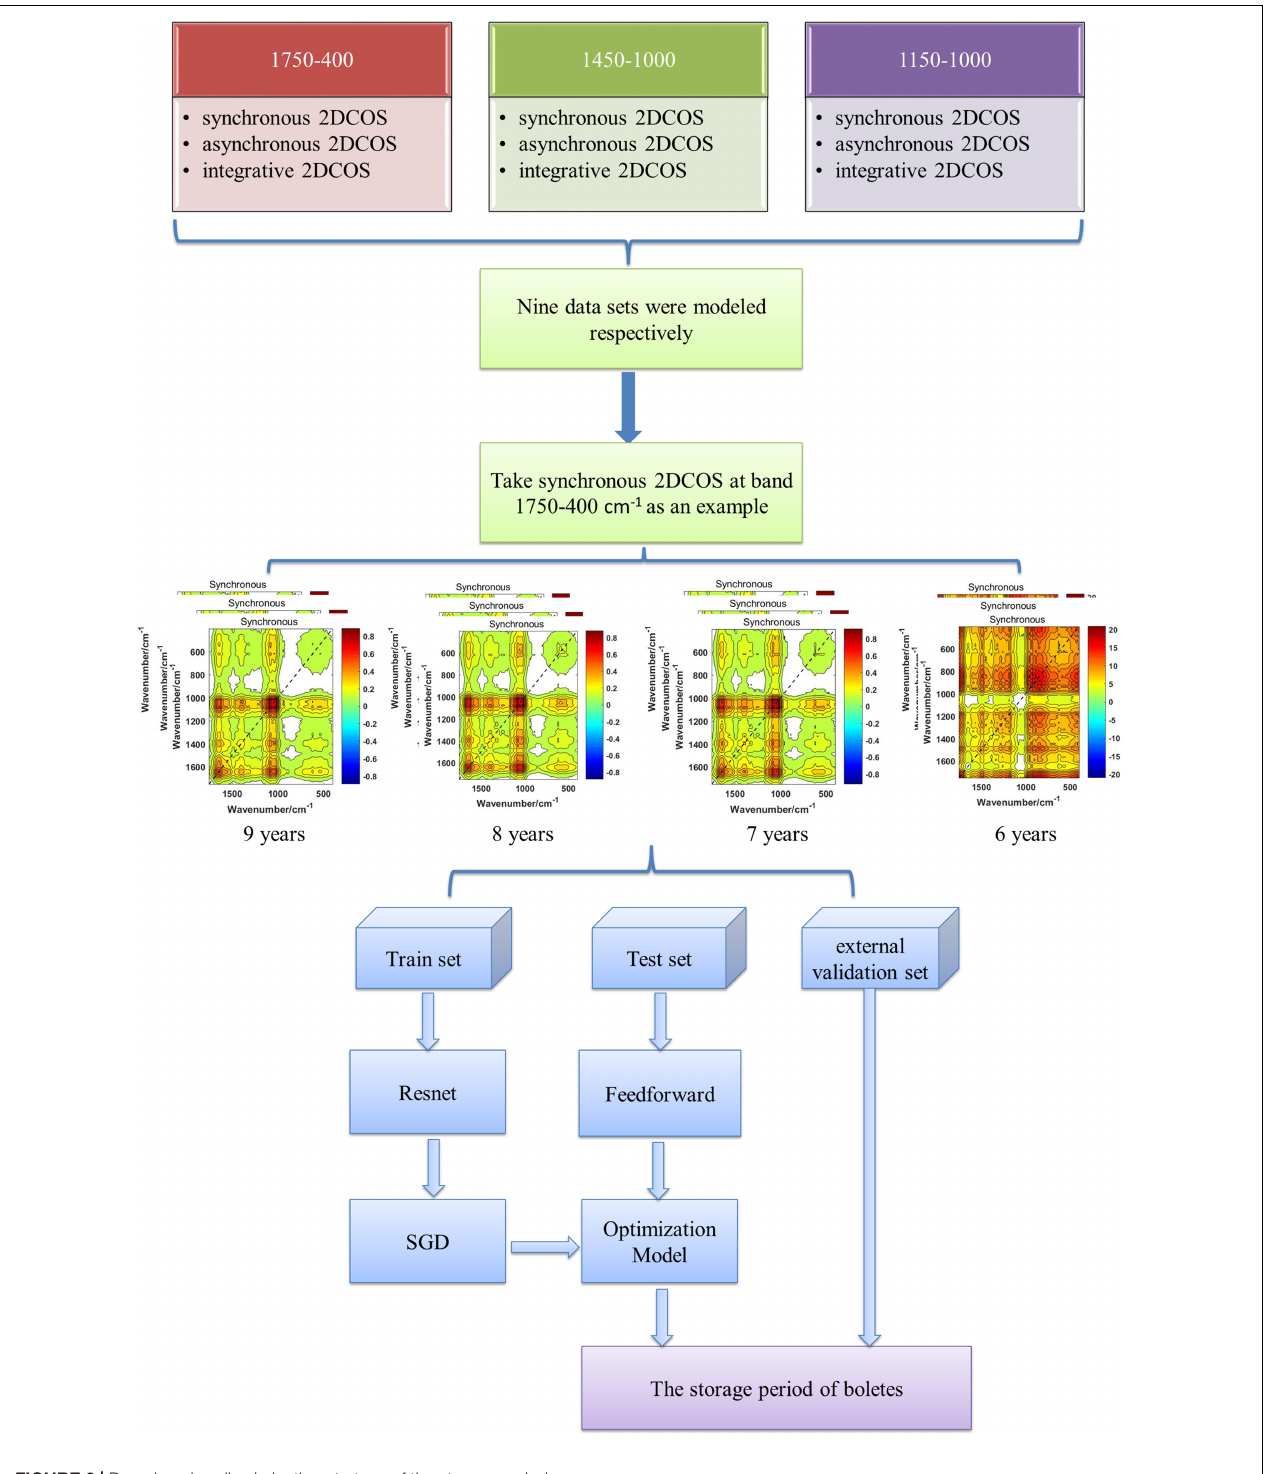
FIGURE 3 | Deep learning discrimination strategy of the storage period.